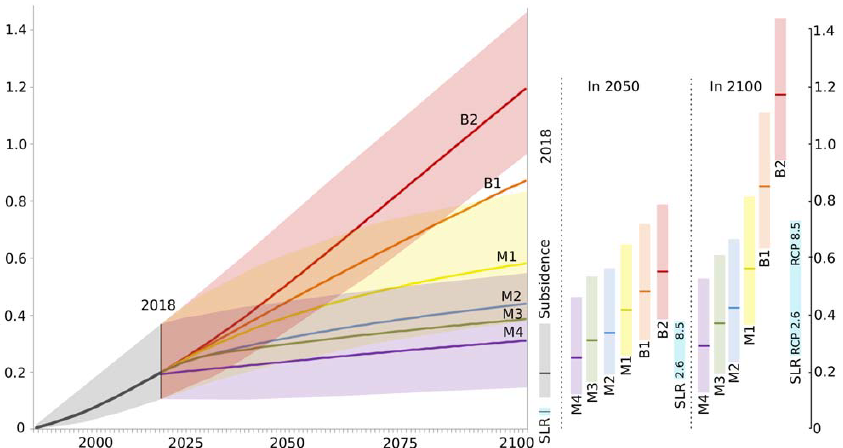
Figure 5. Average cumulative subsidence of the Mekong delta for different groundwater extraction pathways since 2018 (from Minderhoud et al., 2020). This modelling study shows the potential of limiting subsidence when more mitigative pathways are followed (scenarios M1–4 in the